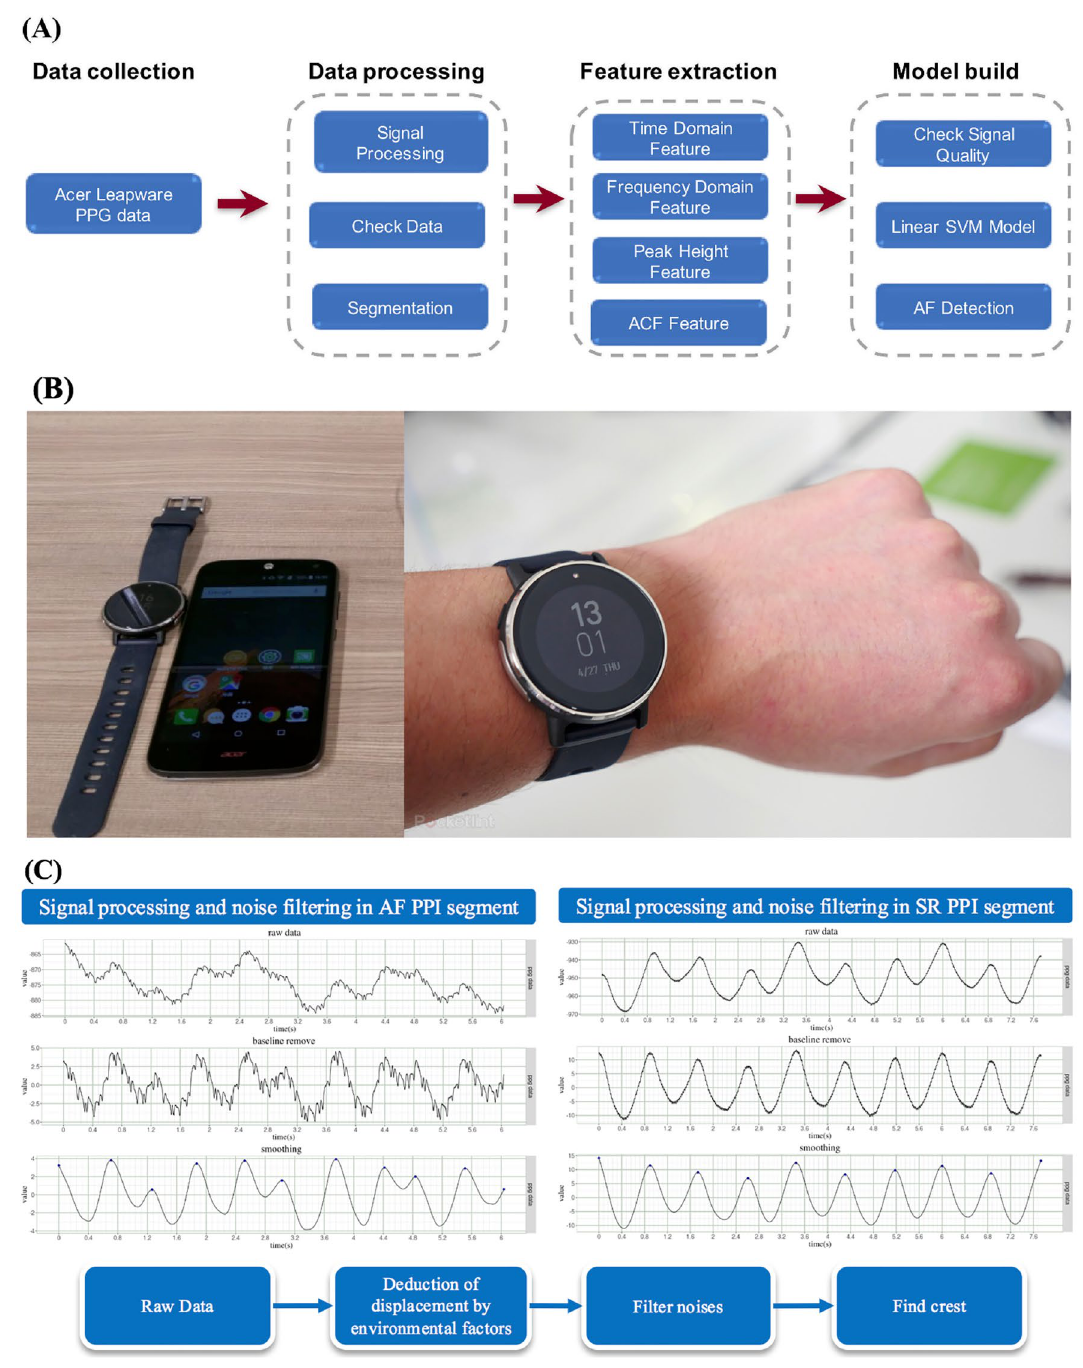
Figure 2. ( A ) Proposed framework of the photoplethysmogram (PPG) to detect atrial fibrillation (AF). ( B ) The wrist-worn smartwatch. ( C ) Signal preprocessing that includes baseline wandering reduction, denoising, and motion artifact